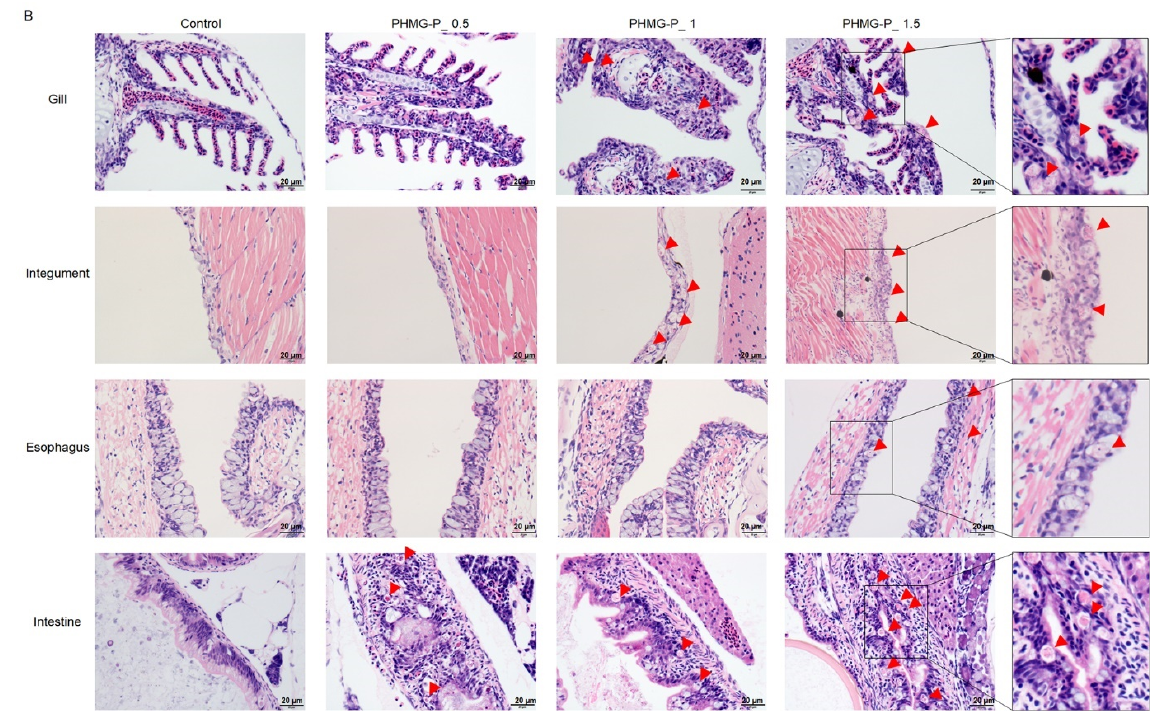
Figure 8. Survival rates and histopathological examination of PHMG-P-treated zebrafish: Four-week-old zebrafish were exposed to 0.5, 1, 1.5, or 2 µg/mL PHMG-P for 5 days. The mortality was